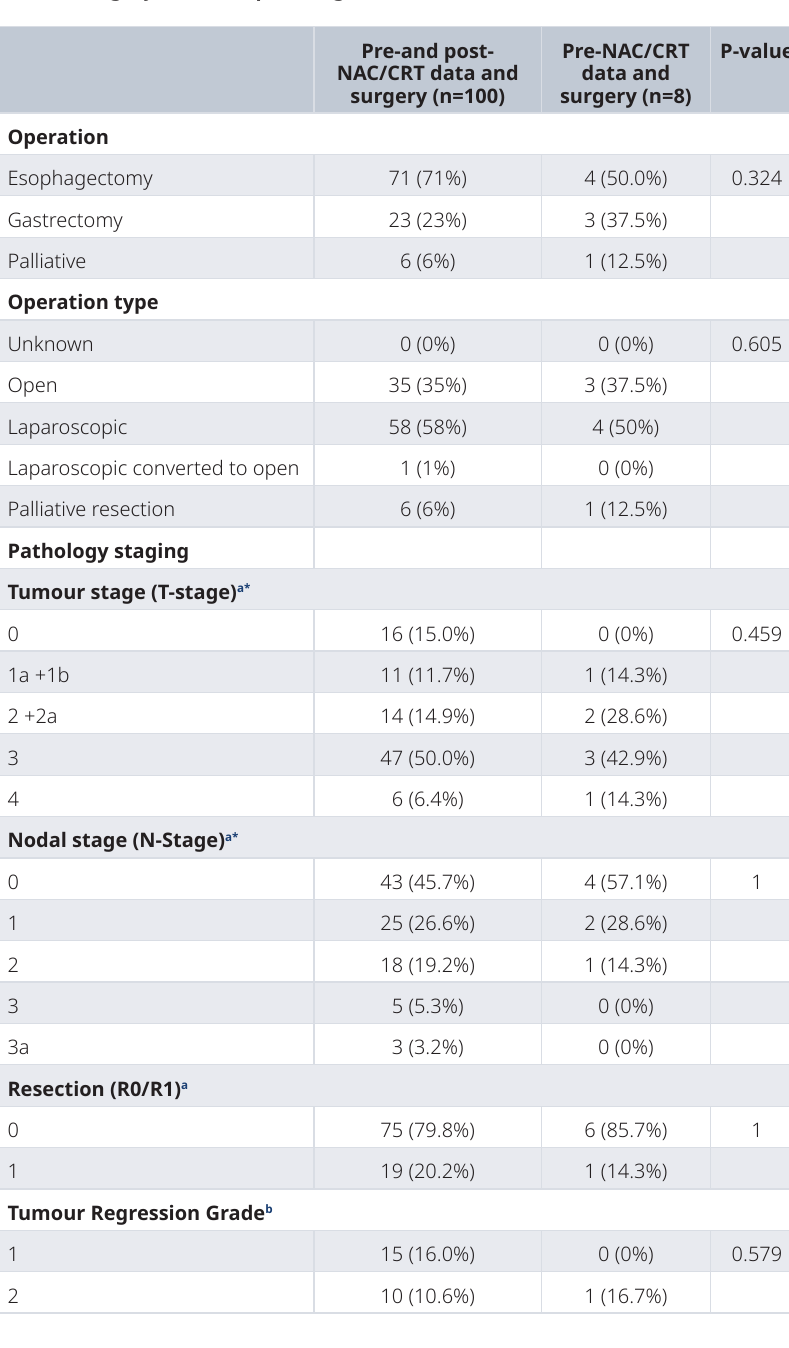
Table 4. Surgery and Histopathological